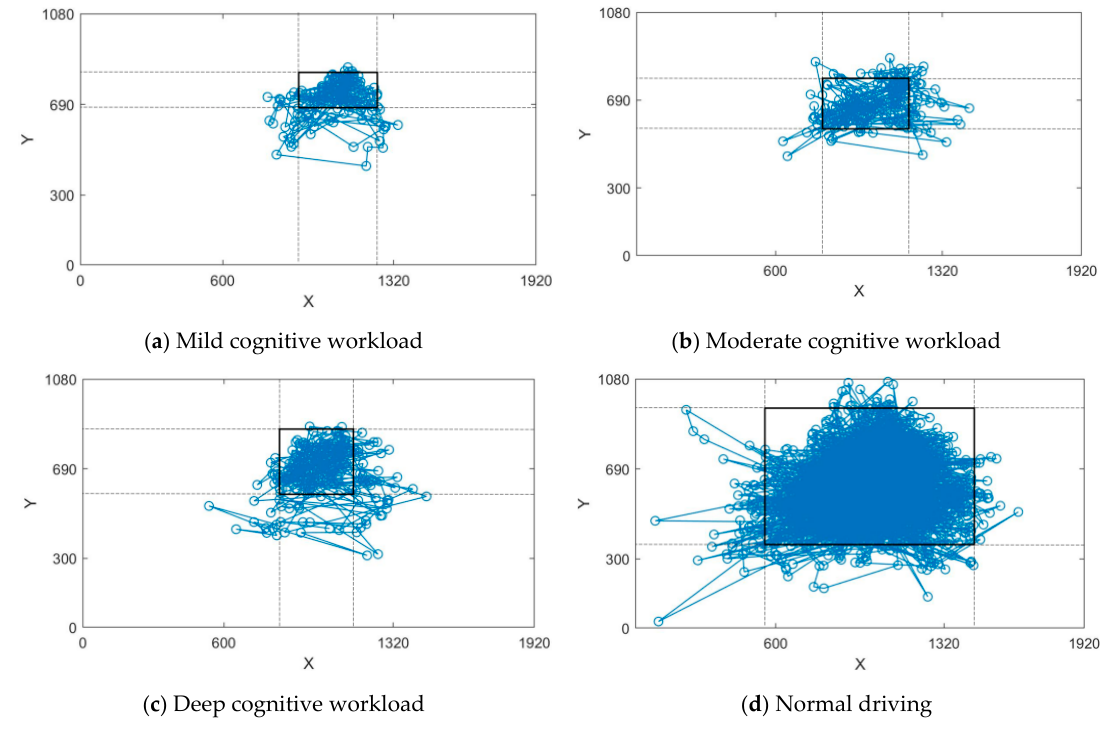
Figure 8. Driver’s fixation transition trajectory under different states. ( a ) Mild cognitive workload ( b ) Moderate cognitive workload ( c ) Deep cognitive workload ( d ) Normal driving. Note: In order to better display the data, we use squares to indicate areas where the data are concentrated.